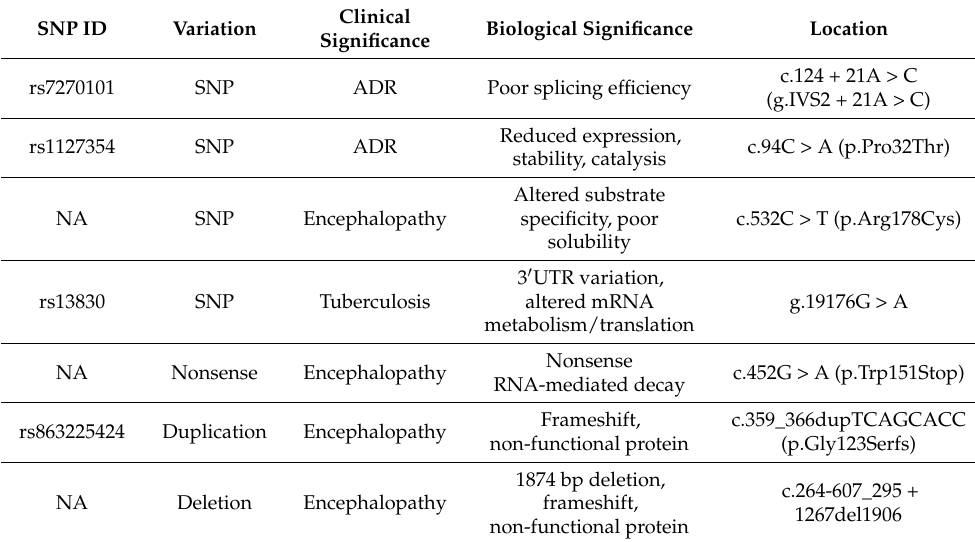
Table 1. Clinically relevant ITPA mutants/variants and their biological